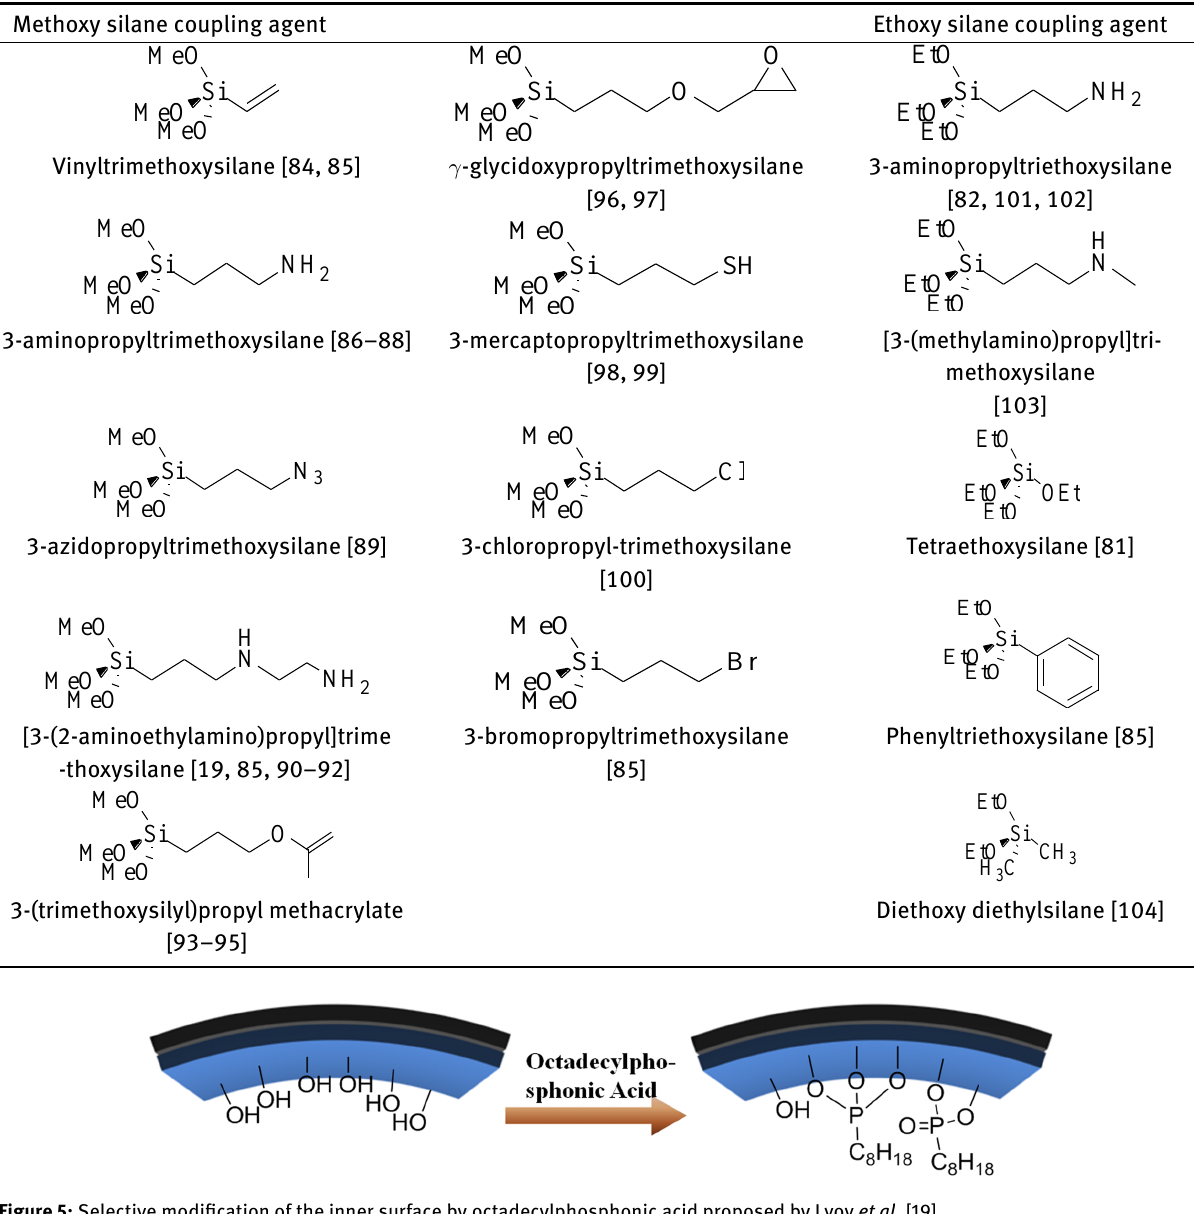
significantly through doping phenyl phosphonic acid mod- ified HNTs into epoxy resin. Lvov et al. [19] modified the HNTs with octadecylphosphonic acid (shown in Figure 5), while the octadecyl phosphoric acid did not react with the outer wall of HNTs. Therefore, the outer wall of HNTs mod- ified by octadecyl phosphate still has a hydrophilic struc- ture, and the inner cavity is a hydrophobic structure. This special structure allows the modified HNTs to form stable micelles in